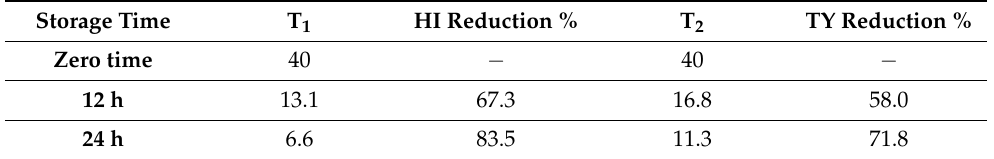
Table 2. Effect of adding B. polymyxa D05-1 culture on the levels of BAs (40 mg/kg) experimentally added to Tallaga